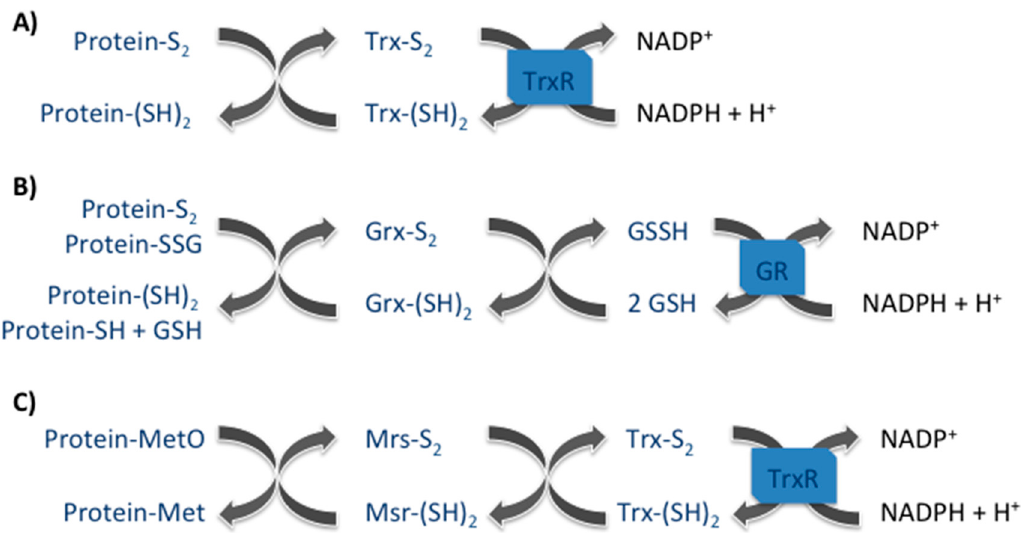
Figure 1. The three major protein repair systems. ( A ) Thioredoxin (Trx) system participates on the reduction of protein disulfide (Protein-S2); ( B ) Glutaredoxin (Grx) system reduces protein disulfide (Protein-S2) as well as protein glutathione mix disulfide (Protein-SSG); and ( C ) Methionine sulfoxide reductase (Msr) system reduces methionine sulfoxides (MetO).